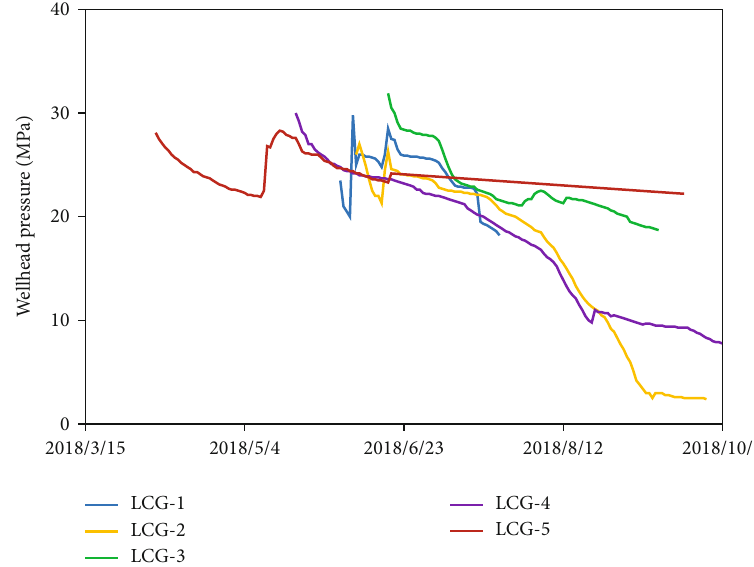
Figure 2: Variation of wellhead pressure of disturbed wells when they are in